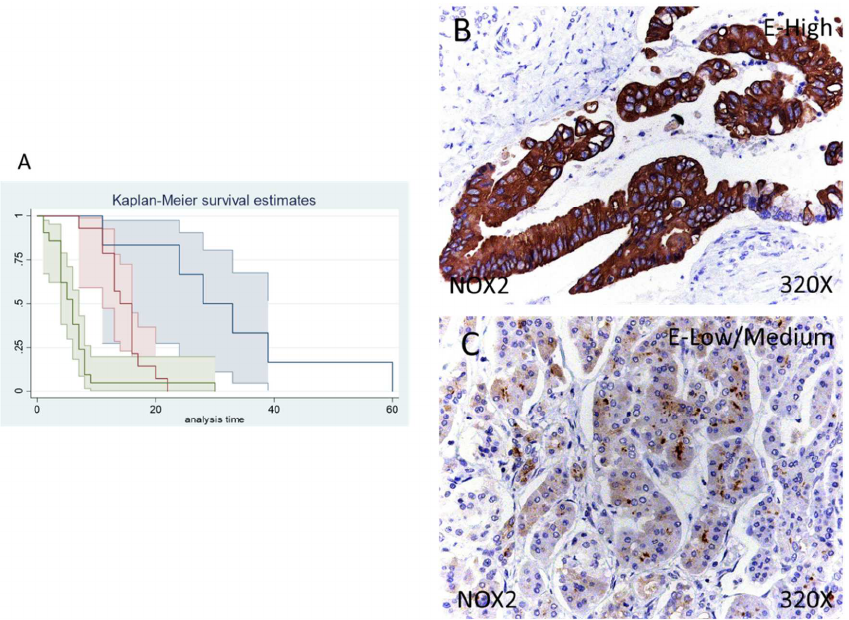
Figure 3. ( A ) Kaplan–Meier curves for survival time according to tumor expression of NOX1. Blue curve = tissue expression classified as negative, red curve = tissue expression classified as low/medium, green curve = tissue expression classified as high. ( B , C ) Images showing the protein expression of NOX1 in patients diagnosed with pancreatic cancer.